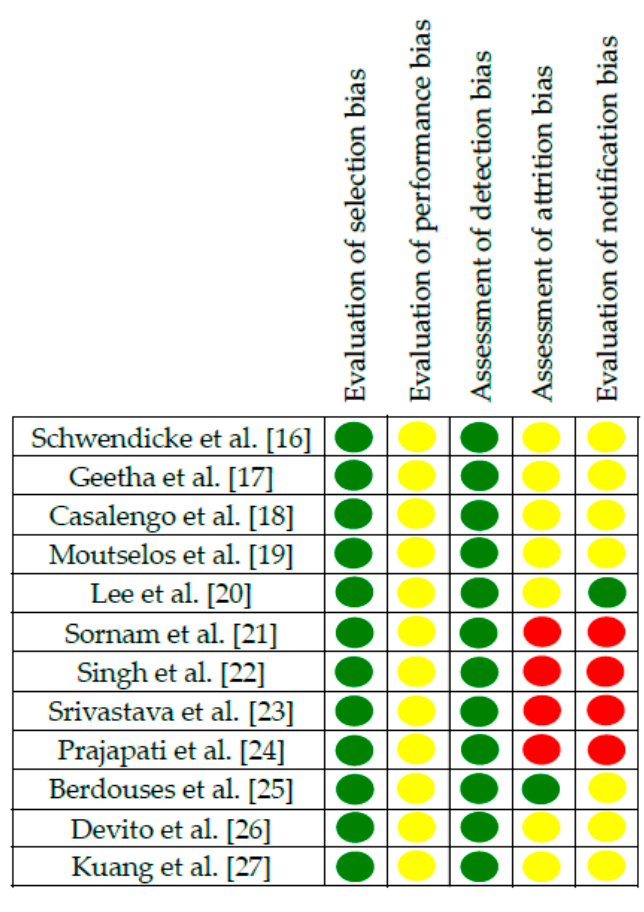
Figure 2. Assessment of risk of bias of included studies.